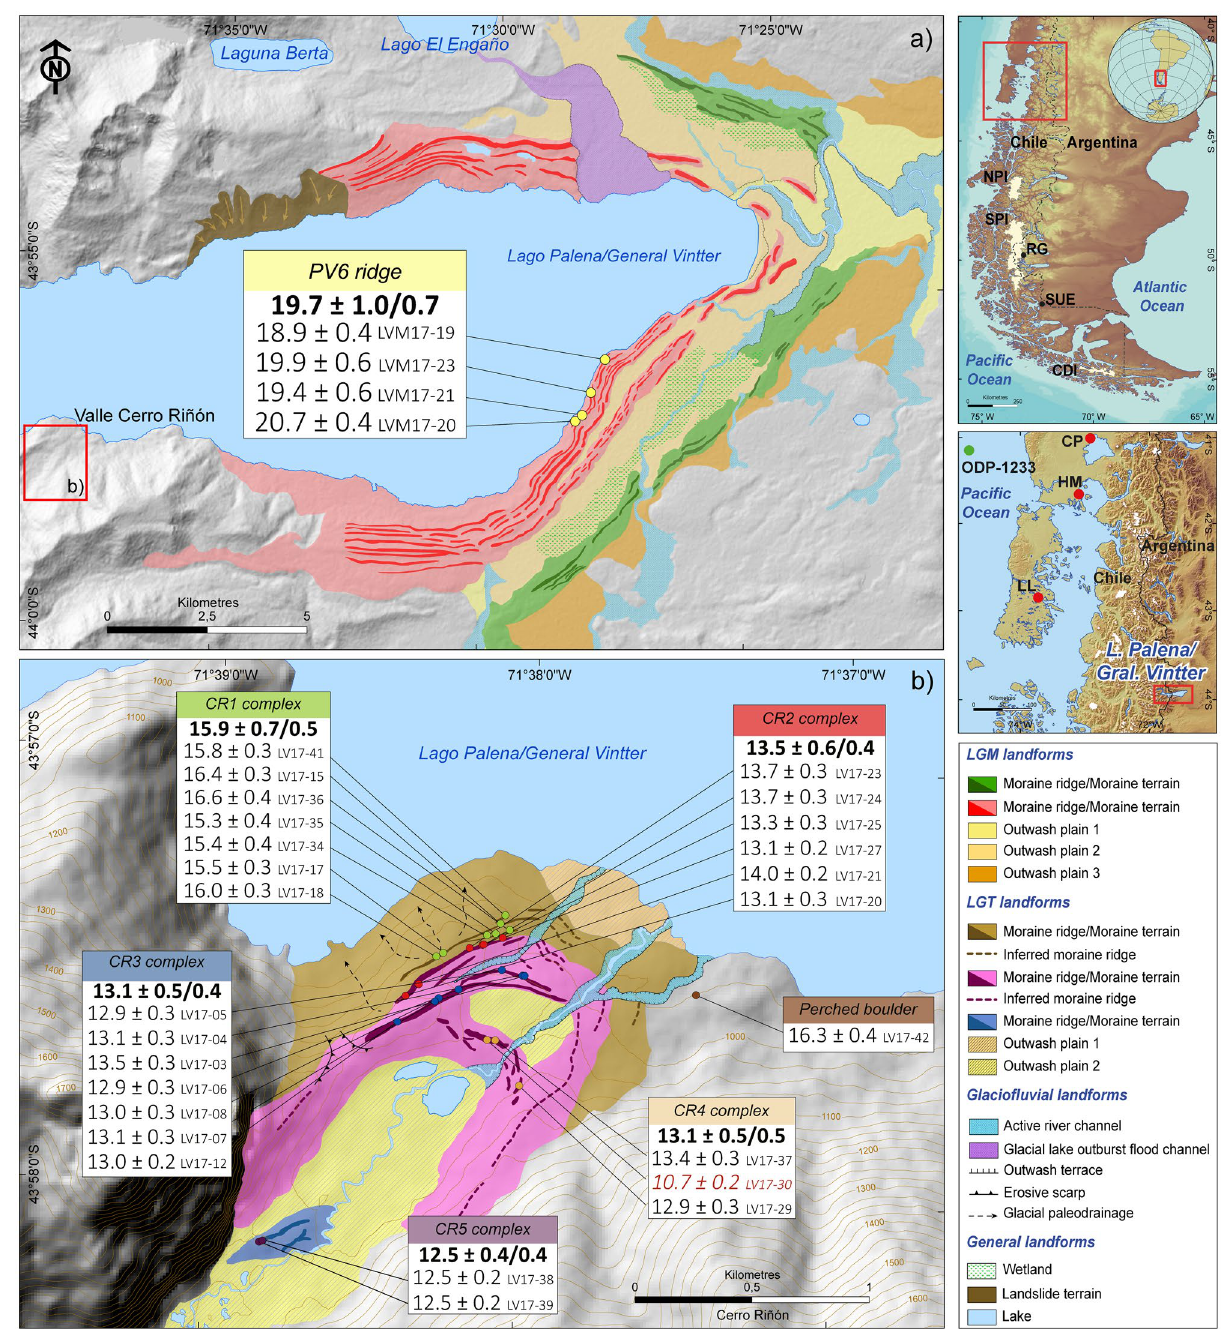
Figure 1. Glacial geomorphology and chronology of the ( a ) Lago Palena/General Vintter ice lobe with 10 Be ages (n = 4) obtained from the innermost moraine ridge (PV6) and ( b ) the Cerro Riñón valley glacier with 10 Be ages (n = 26) obtained from CR1-CR5 moraine complexes and the additional perched boulder. On top of the boxes the mean moraine age is acompanied by 1 standard deviation (σ) and the Standard Error of the Mean (SEM) including a 3% propagated production rate error 20 (Table 1). Individual ages are presented along with internal uncertainty and sample ID. One age in red italics is considered an outlier. Inset maps with the location of sites mentioned in the text. Black dots correspond with glacial chronologies from RG: Río Guanaco; SUE: Seno Última Esperanza. Red dots correspond to paleovegetation reconstruction. LL: Lago Lepué. CP: Canal de la Puntilla. HM: Huelmo mire. Green dot is the location of ODP1233 sediments core. White outlines represent Northern (NPI) and Southern (SPI) Patagonian Icefields and Cordillera Darwin Icefield (CDI). This figure was created on ESRI ArcGIS v10.4 software (www. esri.